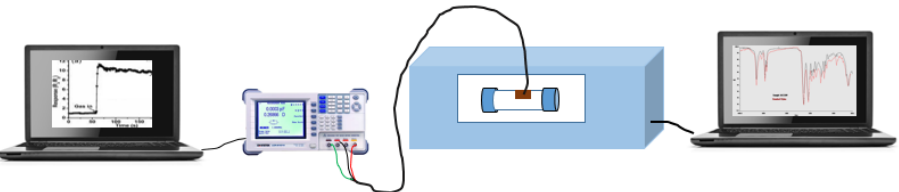
Figure 3. A diagram showing a combined online in situ FTIR and LCR meter setup for sensor testing.